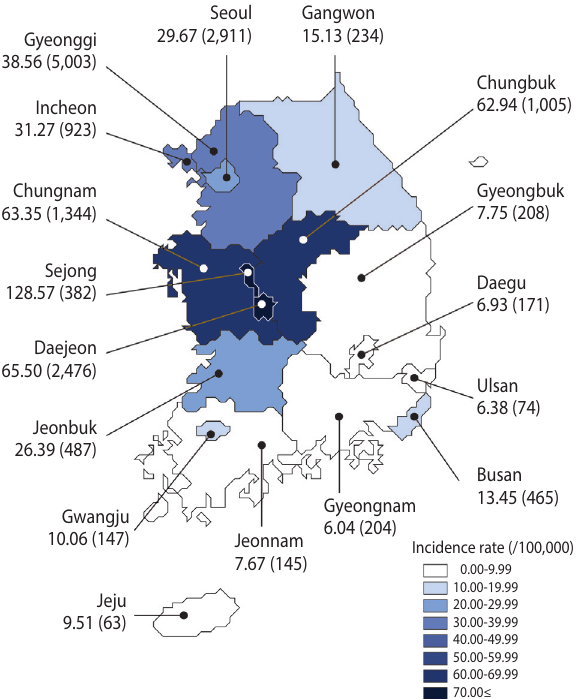
Figure 4. Incidence rate per 100,000 (n) of hepatitis A by area in Ko- rea, 2019 (as of October 13, 2019).